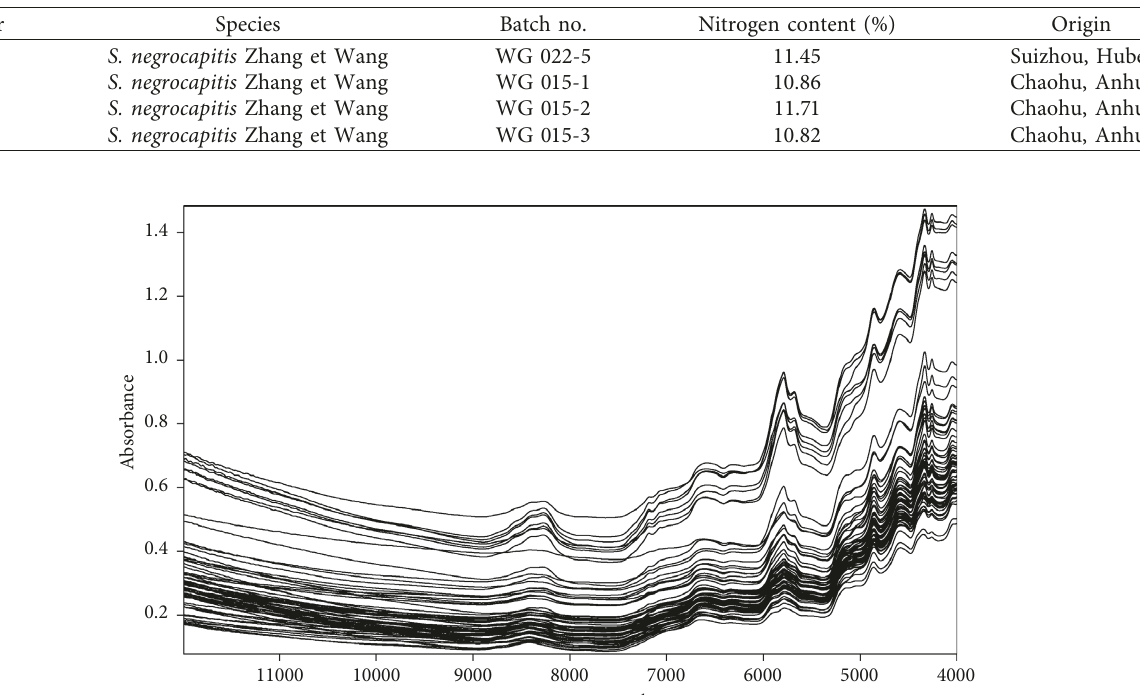
Figure 1: NIR spectra diagram of